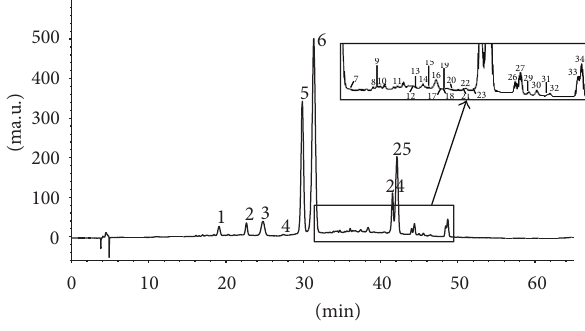
F 3: HPLC-DAD chromatogram at 520nm of anthocyanins of the must from